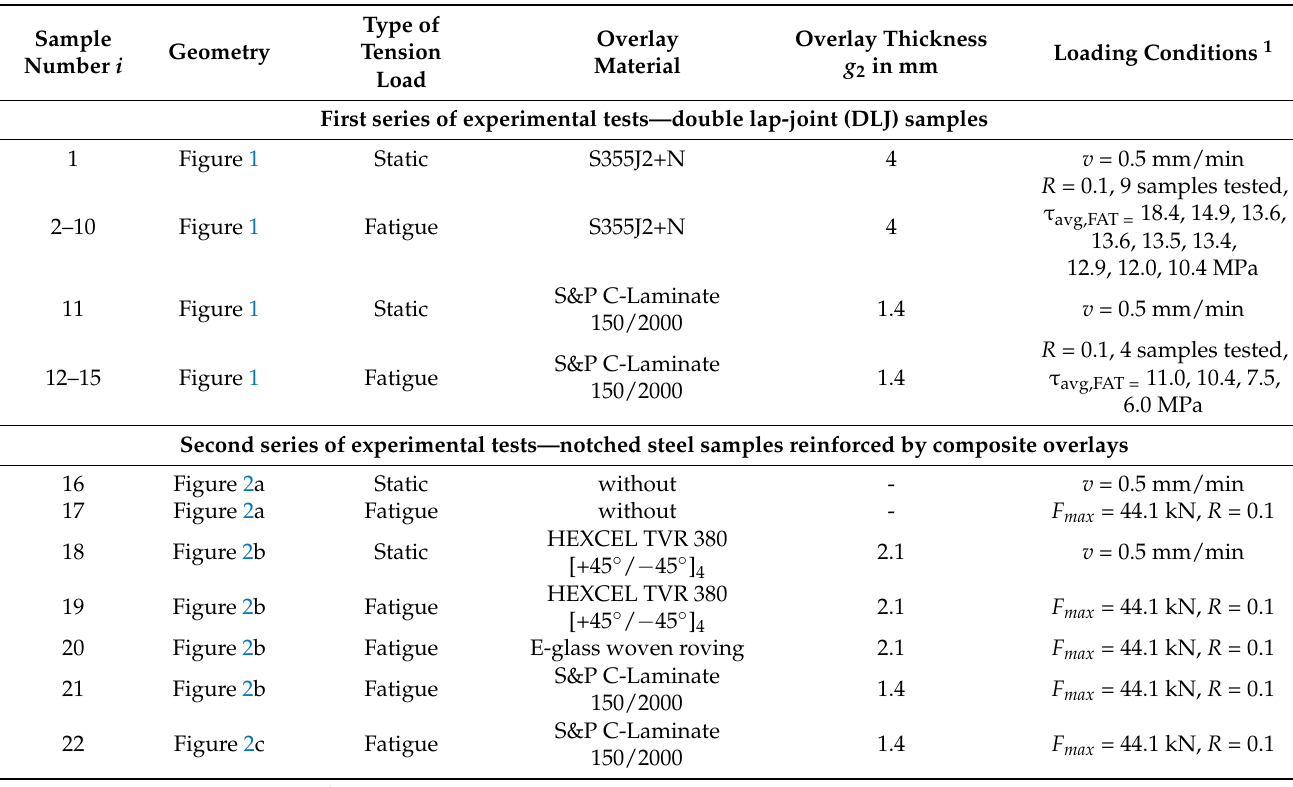
Table 3. Details of experimental research program.